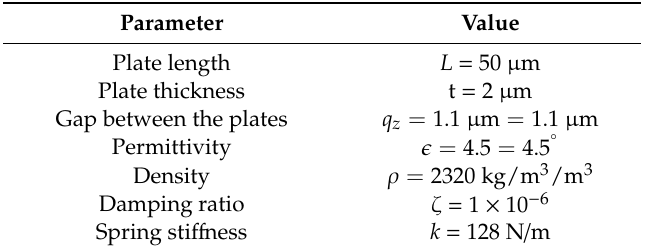
Table 1. Parameters of the RF MEMS device.